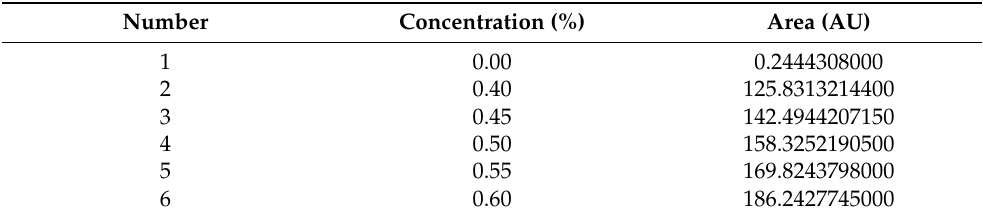
Table 3. Series concentration and series area from the regression data set series of tranexamic acid.